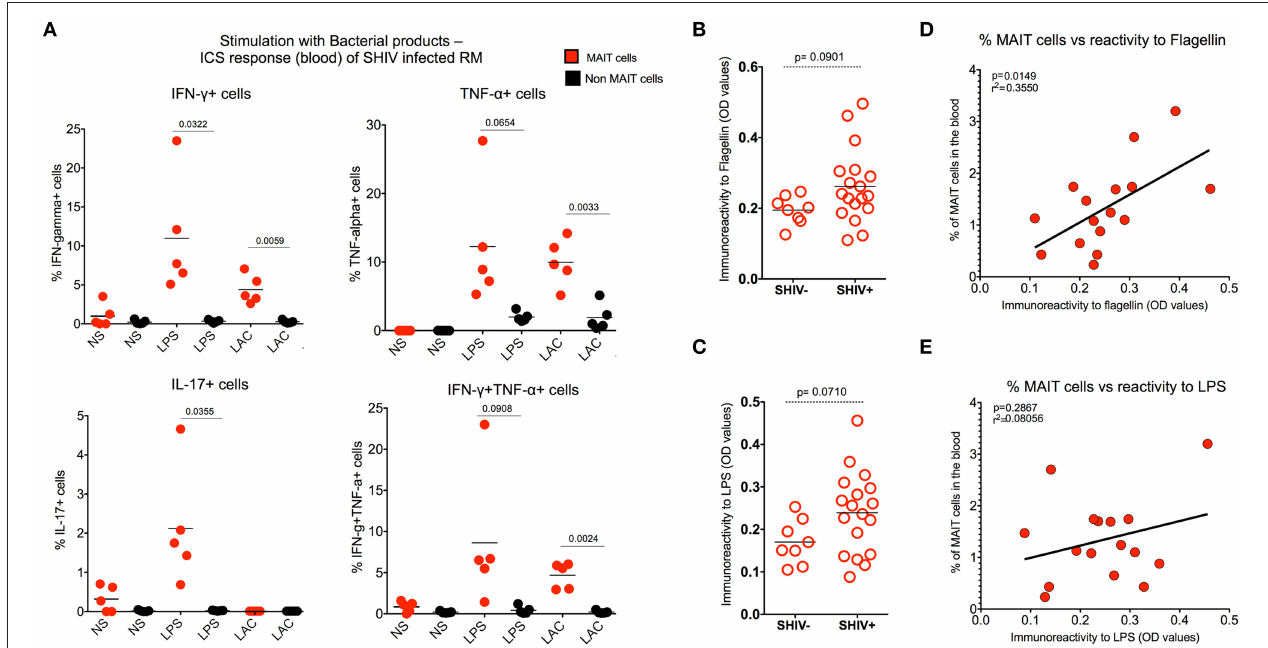
FIGURE 6 | MAIT cells respond to microbial products during chronic SHIV infection. (A) Plots showing the cytokines (IFN- γ , TNF- α , and IL-17) produced by bacterial products (LPS and lactobacillus) stimulated cells ( n = 5), suggesting antimicrobial immunity during chronic SHIV infection. (B) Dot plots showing the higher trend of reactivity to flagellin post-SHIV infection. (C) Dot plots showing the higher trend of reactivity to LPS post-SHIV infection ( n = 17). (D) Plots showing that the frequency of blood MAIT cells correlates directly with the level of immunoreactivity to flagellin ( n = 17). (E) Plots showing that the frequency of blood MAIT cells correlates directly with the level of immunoreactivity to LPS ( n =